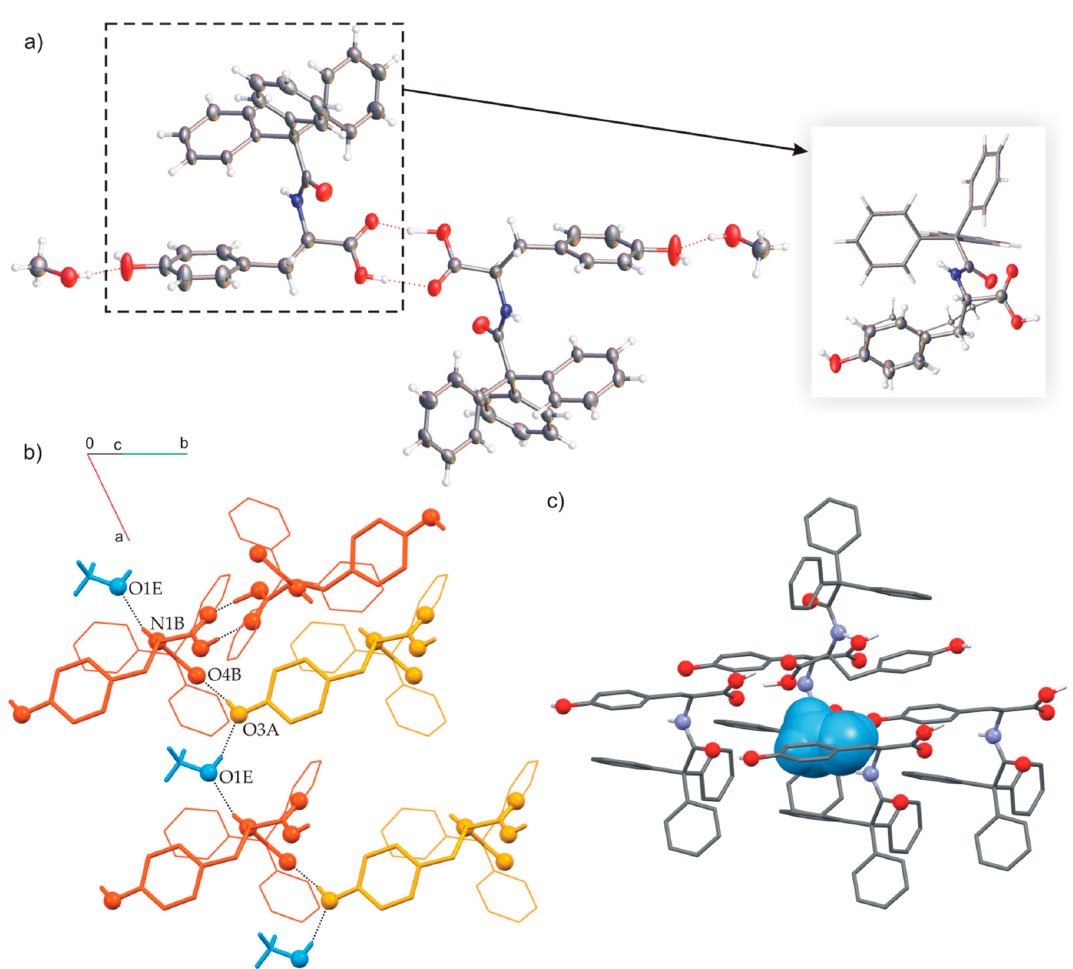
Figure 4. ( a ) The molecular structure of TrCOTyr · MeOH with displacement ellipsoids shown at the 50% probability level, hydrogen bonds are presented as dashed lines (compound crystallize as solid solution of enantiomers – model of disorder for the asymmetric molecule shown in the frame, minor position indicated by thinner bonds); ( b ) 1D motif via hydrogen bonds in crystal structure; ( c ) molecule of methanol trapped between molecules of N -triphenylacetyltyrosine.